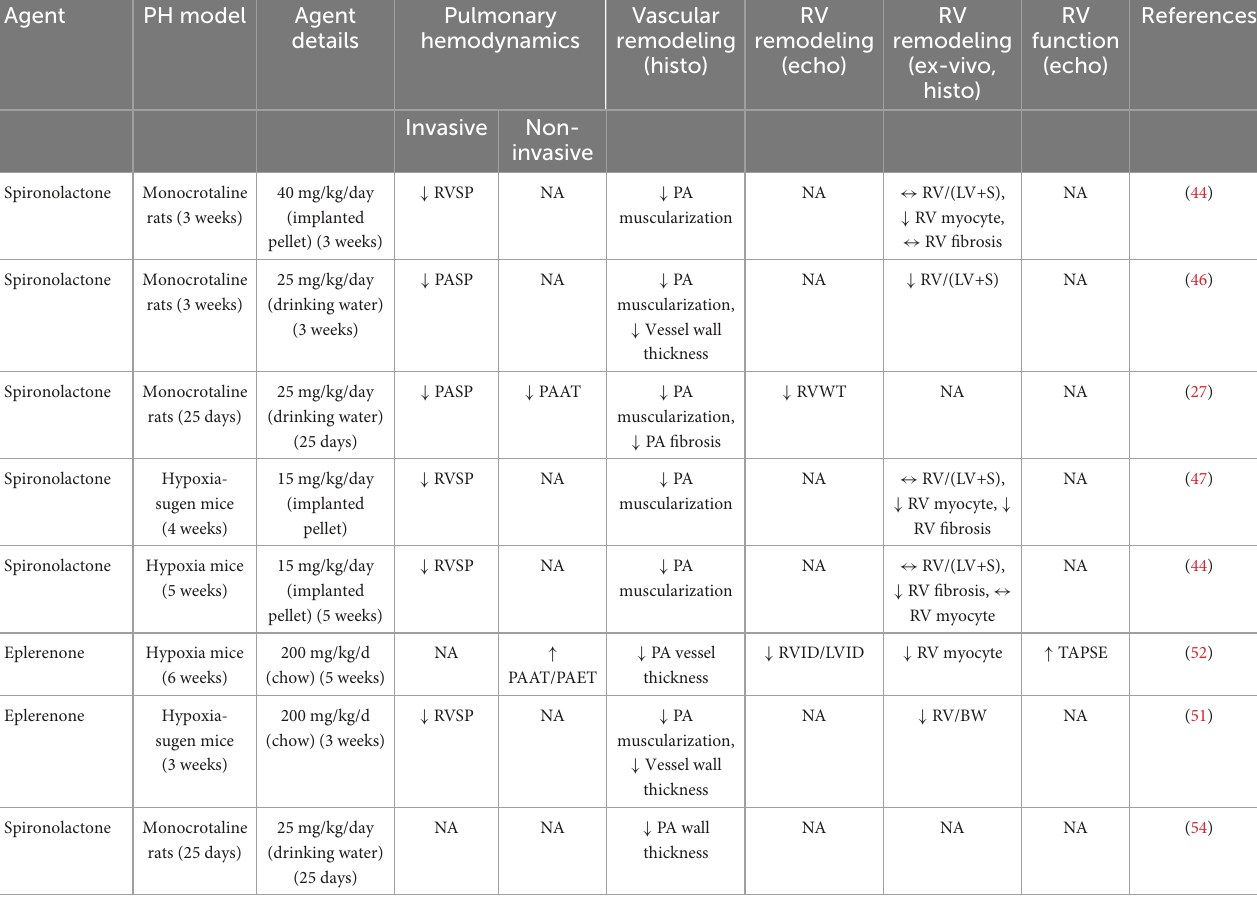
TABLE 1 Summary of studies evaluating the preventive application of mineralocorticoid receptor antagonists (MRAs) in rodent models of pulmonary hypertension (PH). Agent PH